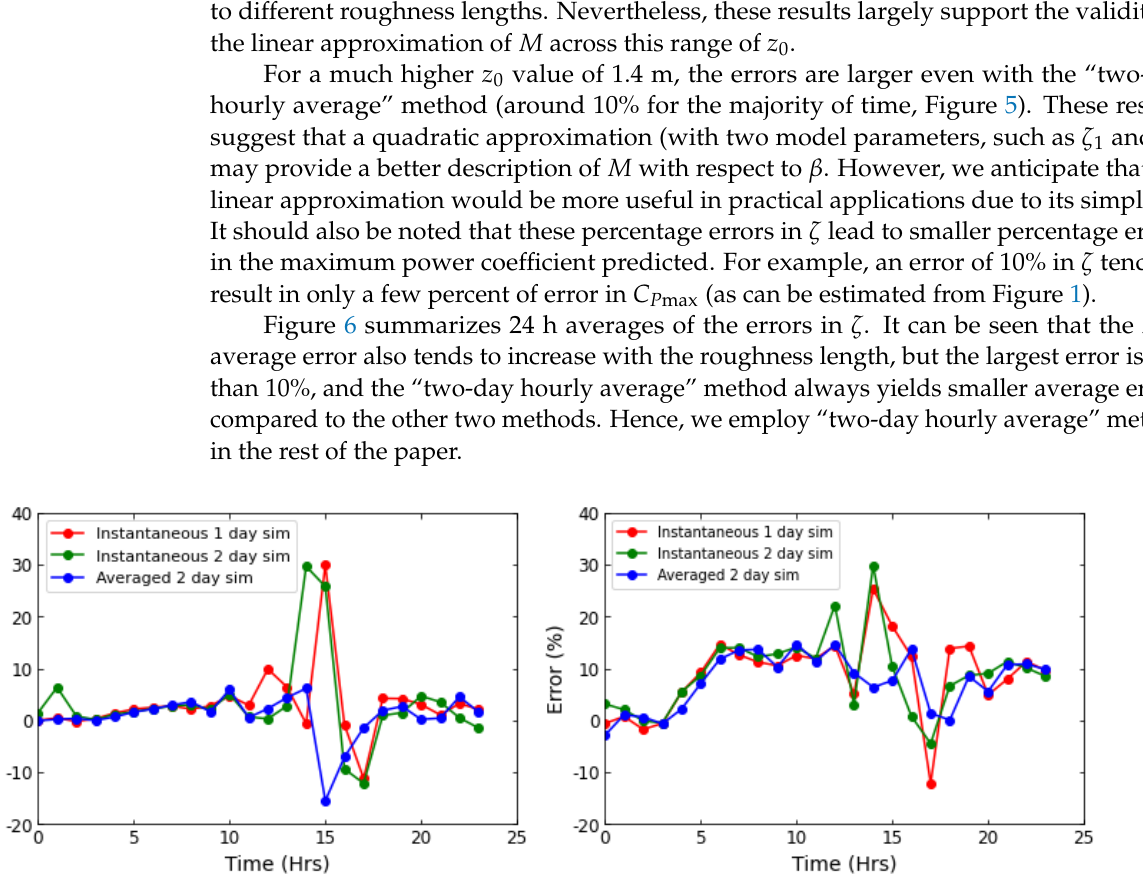
Figure 5. Percentage error in ζ when the values of ζ obtained for the case with z 0 = 0.05 m are used as approximations for a higher roughness case: ( left ) z 0 = 0.1 m ( right ) z 0 = 1.4 m.